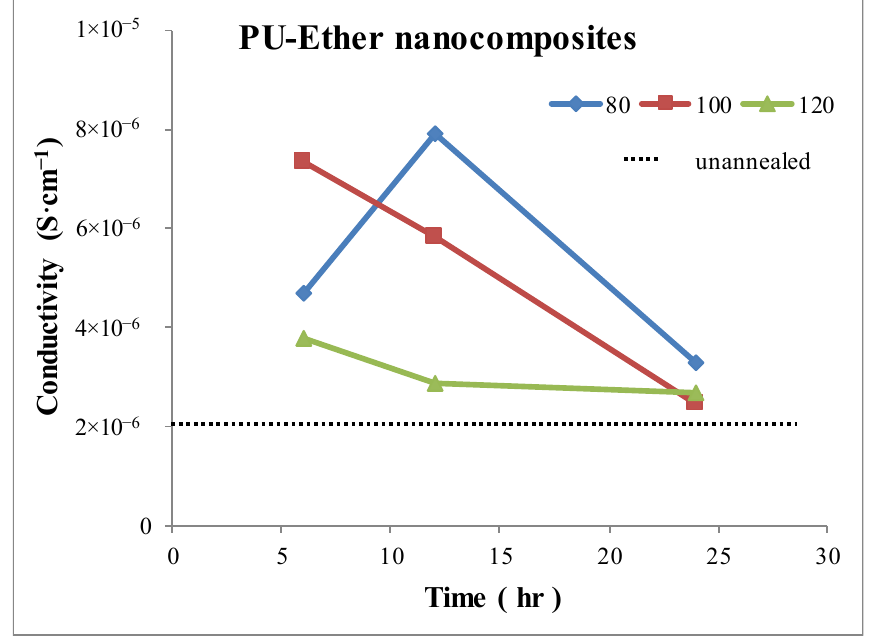
Figure 8 . Conductivities of PU - Ether / MWCNT nanocomposites under various annealing conditions . Considering the PU - Ester / MWCNT nanocomposites in Figure 7, the annealing temperature of 100 °C had higher conductivity . According to the DSC results, the segregated hard - segment phase tended to crystallize at an annealing temperature over 100 °C . This implies that the crystallization accommodated the movement of MWCNTs to form the conductive network . However, a more ordered structure of the hard domain may have disrupted the formation of the MWCNT network, resulting in the decrease in conductivities of the PU-Ester nanocomposites annealed at 120 ◦ C. Therefore, the highest conductivity of 7.12 × 10 − 6 S · cm − 1 was observed at an annealing temperature of 100 ◦ C for 6